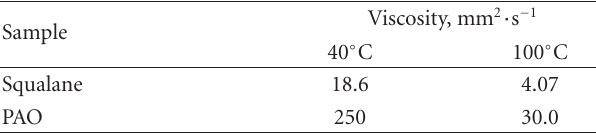
Figure 2: Configuration of specimen of tribotester. Table 1: Viscosity of base fluid.